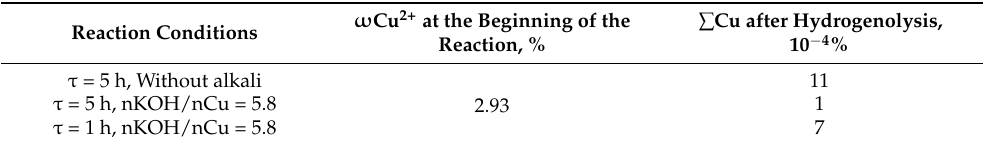
Table 2. The residual copper content in the supernatant solutions measured by XRF. Conditions: T = 220 ◦ C, p(H 2 ) = 3.0 MPa, Gly/Cu = 50 mol, Gly/H 2 O = 4.1 vol, precursor salt = Cu(OAc) 2 . Reaction